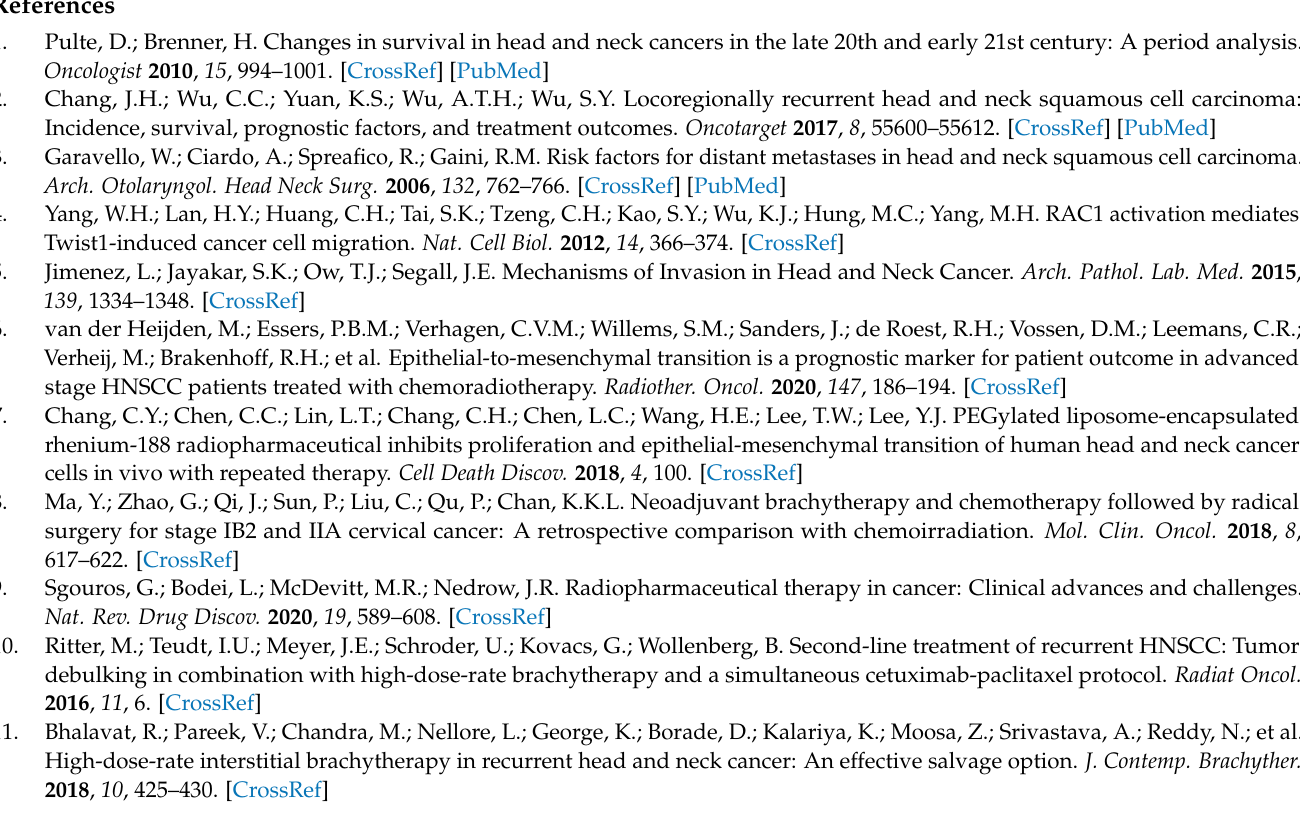
(B) The activity of the tumor area at different time points; Figure S2: Photothermal therapy treatment of pAuNS. (A) Theraml imaging of pAuNS-mediated PTT. (B) Comparison of tumor growth in pAuNS and pAuNS-mediated PTT. (C) H&E staining of HNSCC tumor. The nuclei and the cytoplasm were stained with haematoxylin (blue) and eosin